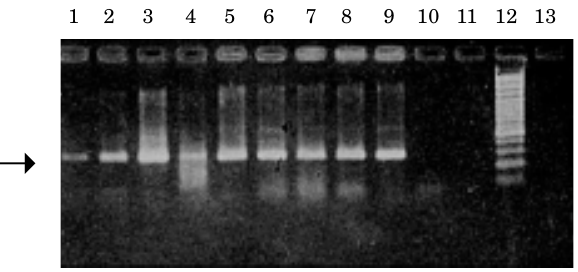
Fig. 3. RT-PCR detection of Hop stunt viroid from symp- tomatic (lanes 1–8) and symptomless (lane 10, 11) plum trees. Lane 9=infected control; lane 13=healthy control; lane 12=100 bp marker